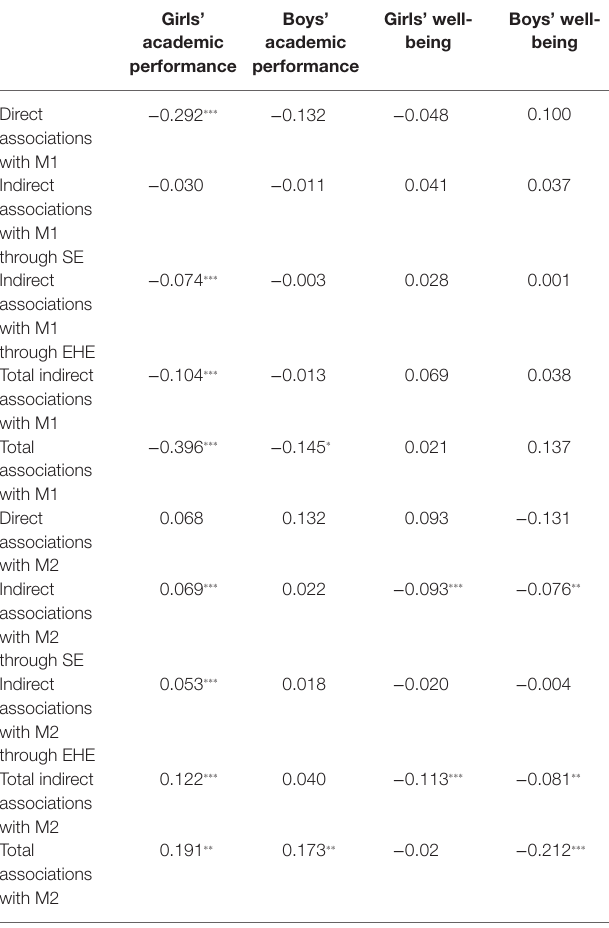
TABLE 7 | Standardized direct, indirect, and total associations across female group and male group in Study 2. Girls’